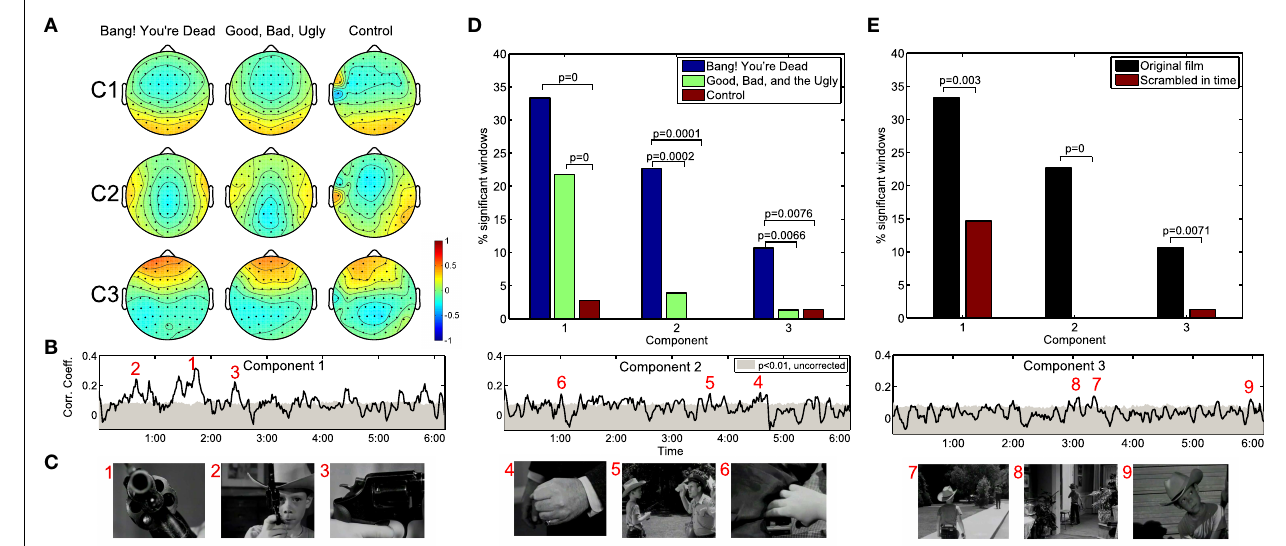
statistically significant correlations in the first component (D) . On the other hand, any extended periods of statistically significant correlation fail to arise during the control clip. Moreover, when presenting “Bang!You’re Dead” with its scenes scrambled in time, a significant reduction in neural correlation ensues (E)